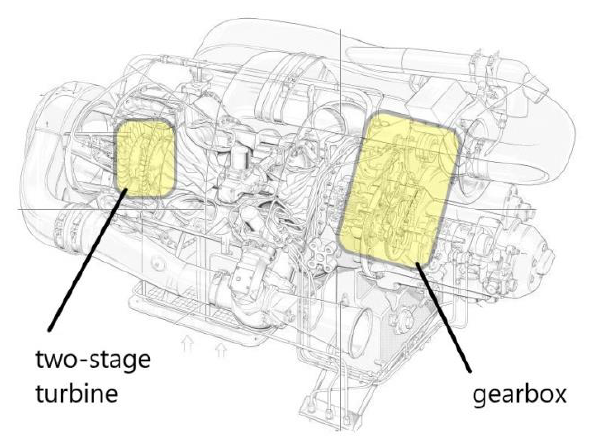
Figure 10. Cross-section of the APS3200 engine (Adapted from [23]).